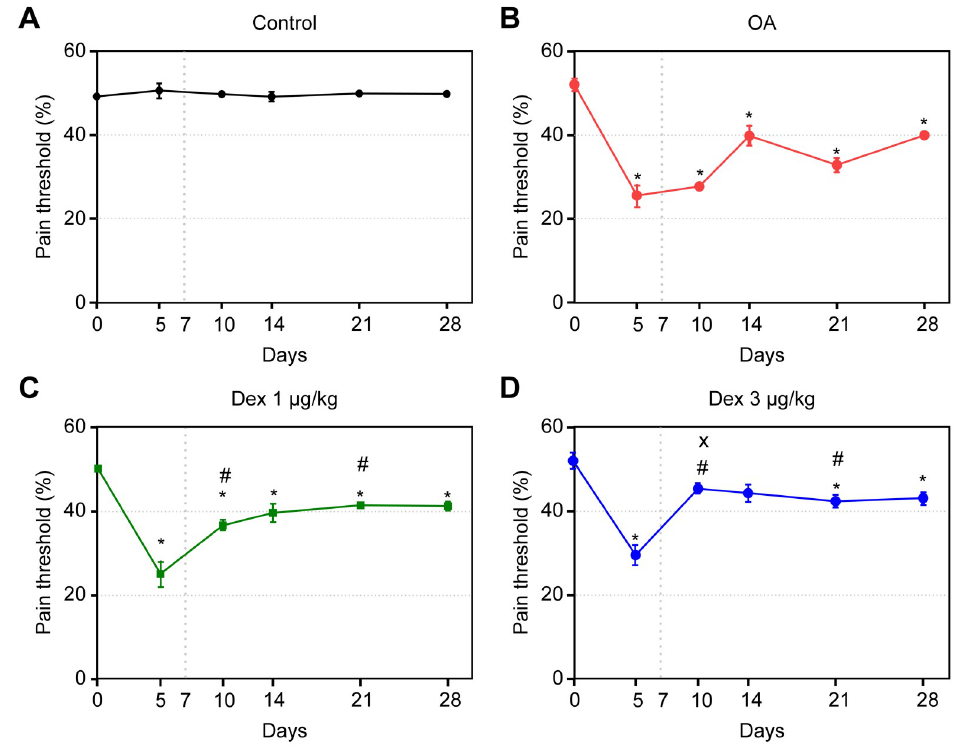
Fig 3. Assessment of tactile allodynia in rats treated with normal saline (0.9% NaCl, i.a.) or dexmedetomidine (1 μ g/ kg or 3 μ g/kg, i.a.). Symbols and vertical lines represent the mean ± standard error of the mean. The vertical dotted line represents the onset of treatment. � indicates a significant difference compared with the control group. # indicates a significant difference compared with the OA group. + indicates a significant difference compared with the DEX 3 μ g/kg